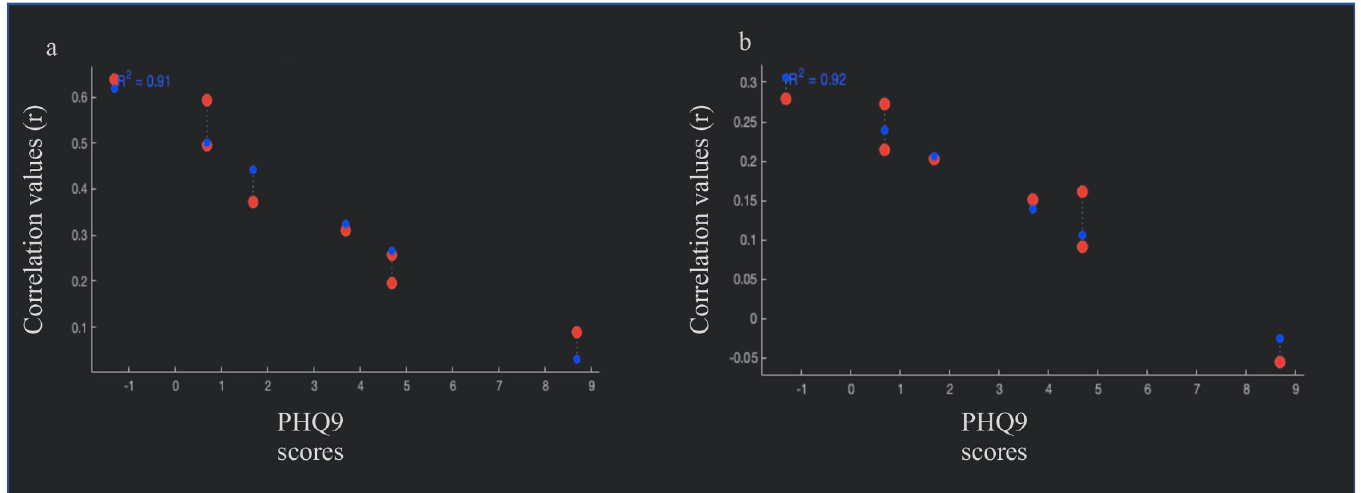
Fig 2. Correlation between demeaned PHQ9 scores and functional connectivity between (a) the fusiform cortex and hippocampus and, (b) the cerebellum and the posterior cingulate. Note: red dots = observed values; blue dots = fitted values.